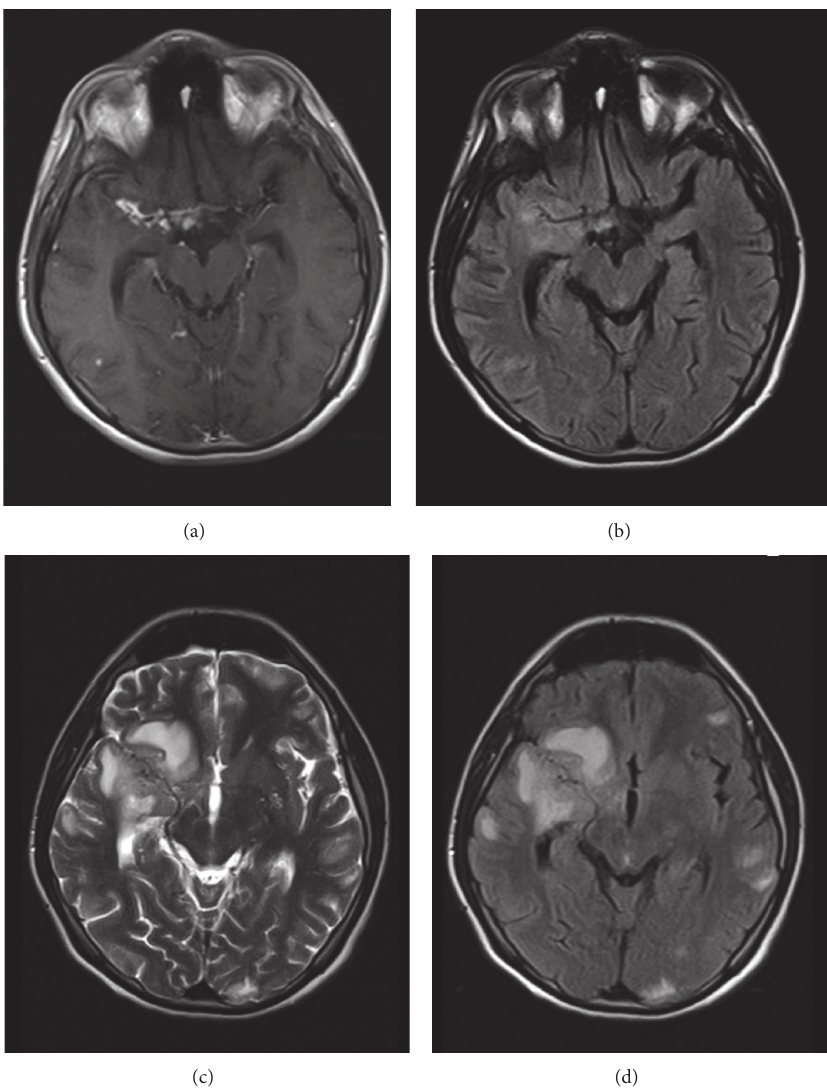
Figure 2: A contrast of an initial diagnosis against its progression after one month T1A (a), FLAIR (b), a diagnosis 45 days later with T2A (c), and FLAIR (d) images. A meningeal contrast is involved and a thickening compatible with a diagnosis of basal meningitis is visible in the neighborhood of the right sylvian fissure and basal cisterns (a) and increments of parenchymal T2 intensity in that region (b). Instead of antituberculosis treatments working, on the forty-fifth day mark, parenchymal lesions have been proven to grow and new lesions have appeared (c,